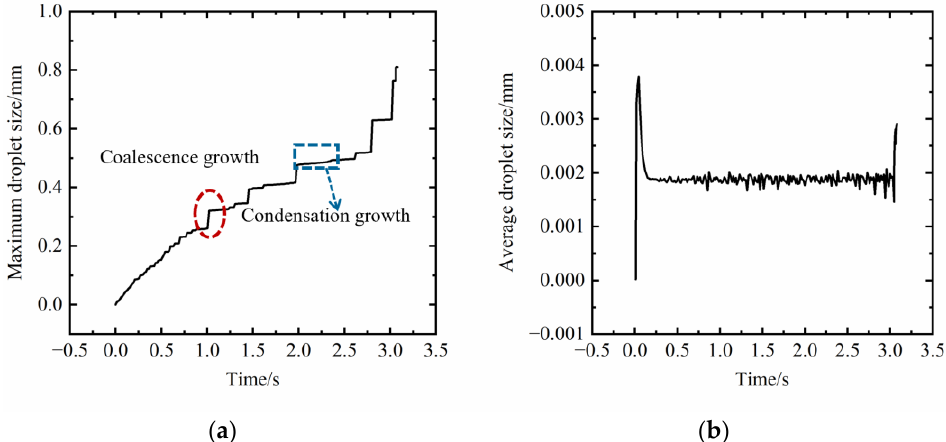
Figure 11. Comparison of size of maximum droplet and average droplet; ( a ) Maximum droplet size and ( b ) Average droplet size.